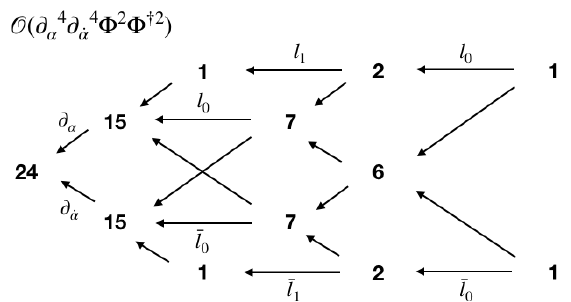
Figure 8. This is the tree diagram for ∂ 4